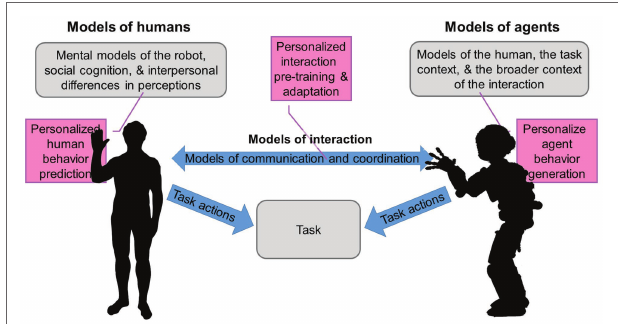
FIGURE 1 | Cognitive human-robot interaction (HRI) as presented and discussed by Mutlu et al. (2016) as an example of human-agent interaction (HAI) (blue and gray). Various interaction challenges might be tackled applying cognitive models and exhibit strong potential for personalization (magenta). For instance, human behavior prediction (models of humans), interaction pretraining and adaptation (models of coordination), and generating agent behavior from human models (models of agents).